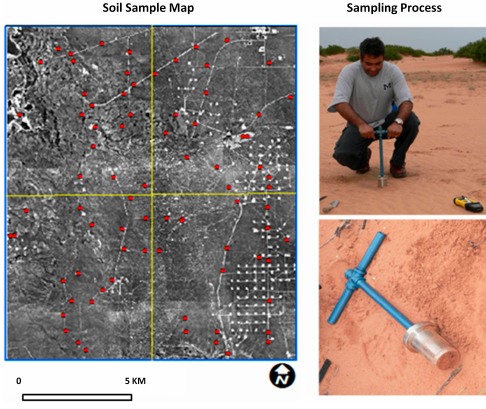
Figure 4. Distribution of soil samples collected for in situ soil moisture measurements.